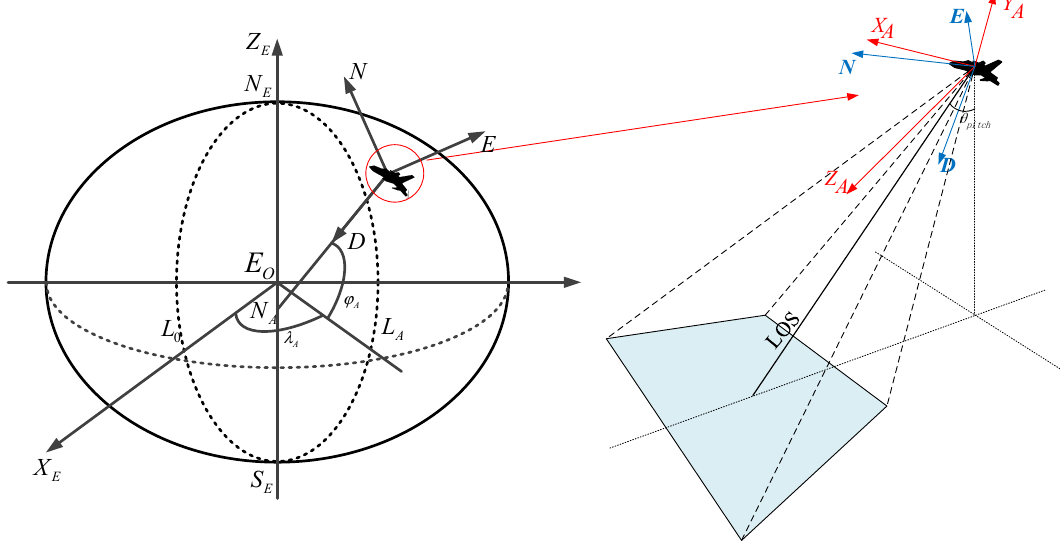
Figure 10. Schematic diagram of the coordinate frames.